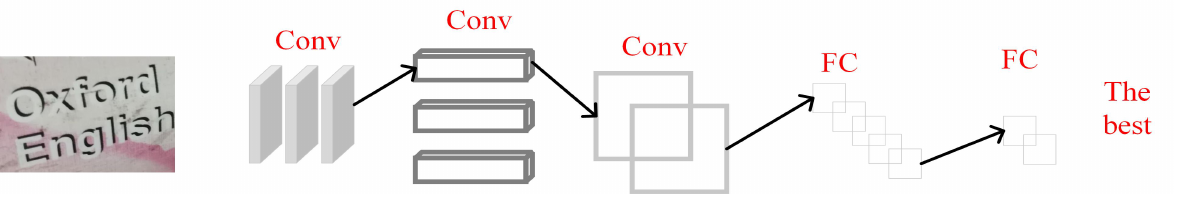
Figure 5. End-to-end structure